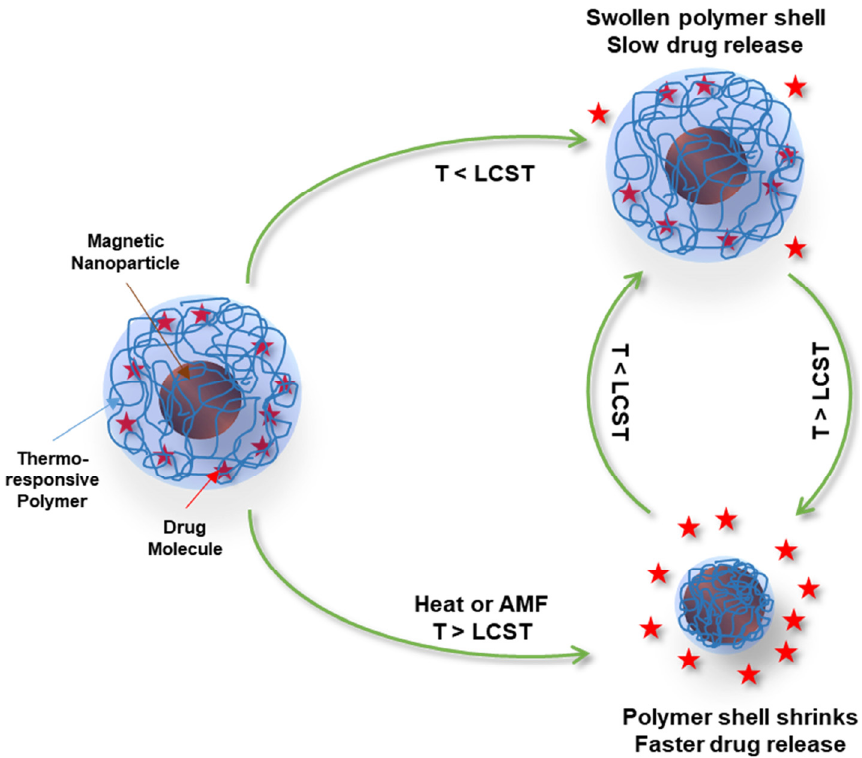
Figure 23. Illustration of the reversible swelling–collapse behavior and drug release from thermoresponsive polymer-magnetic NP composites upon heating or application of an alternating magnetic field (AMF). Adapted with permission from reference [89]. Copyright 2010 Elsevier.